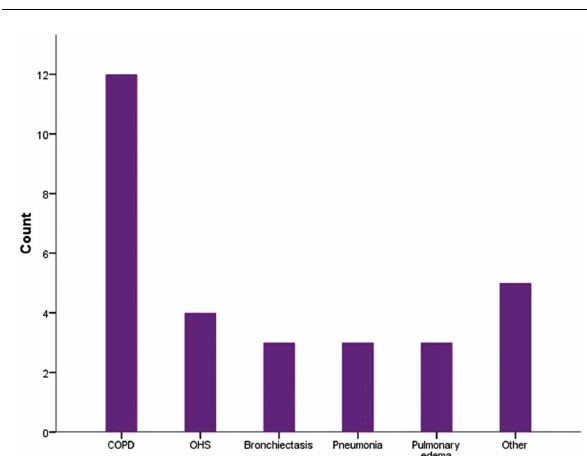
Underlying disease in mechanically ventilated patients in both groups. COPD, chronic obstructive pulmonary disease; OHS, obesity hypoventilation syndrome.